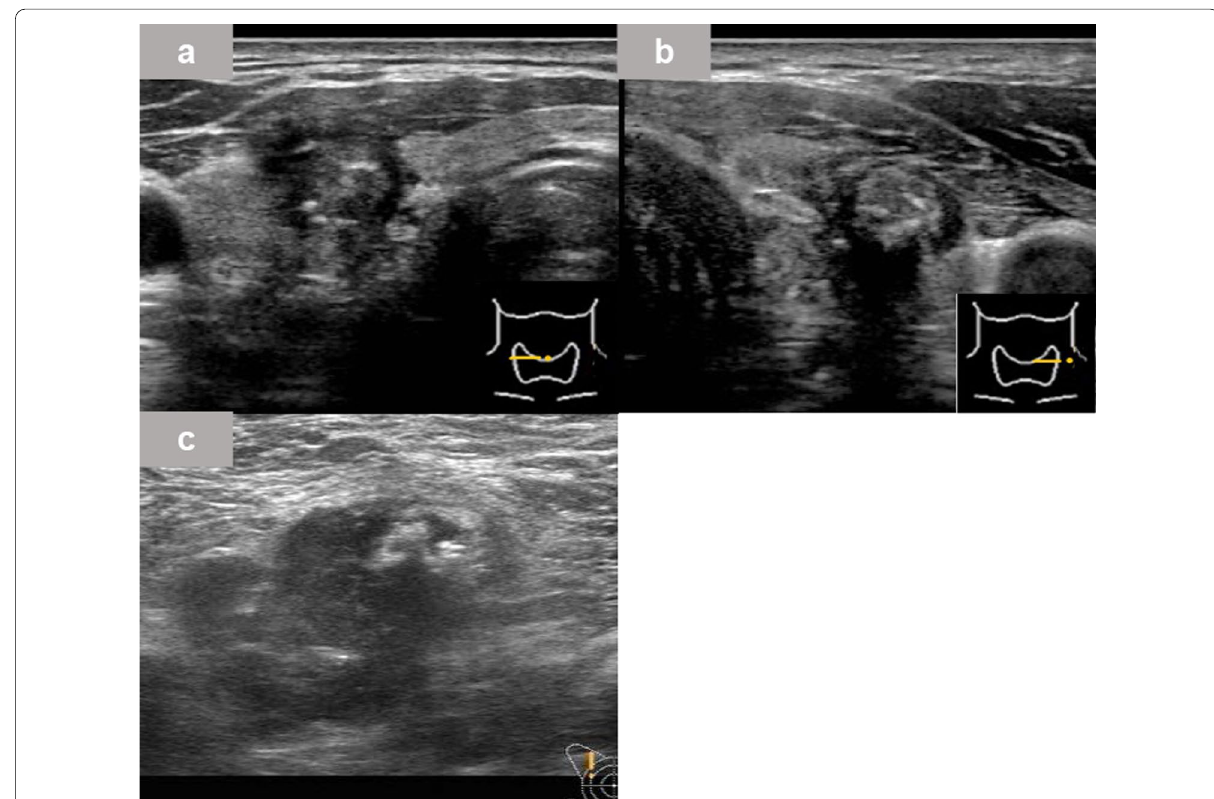
Fig. 2 Ultrasonography findings. a , b Irregularly shaped, ill-defined, hypoechoic mass was seen in the right ( a ) and left ( b ) lobes of the thyroid gland. There were hyperechoic spots with an acoustic shadow. c Right axillary tumor was a hypoechoic tumor. It had a well-defined and rough border. It showed internal heterogeneity and its size was 30 mm. There was no obvious enlargement of surrounding lymph nodes